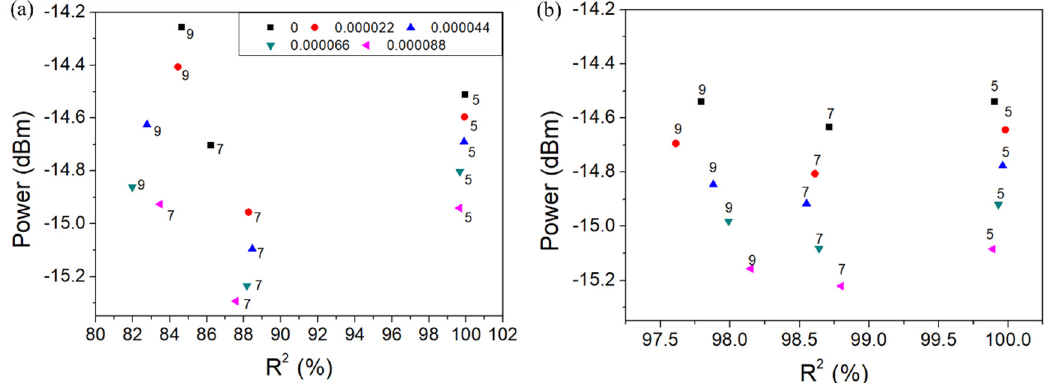
Figure 10. Amplitude of the cladding mode No. 10 after Gauss fitting in terms of SRI change 8.8 × 10 − 5 for wavelength resolution 0.14 nm (unweighted ( a ) and weighted ( b )).